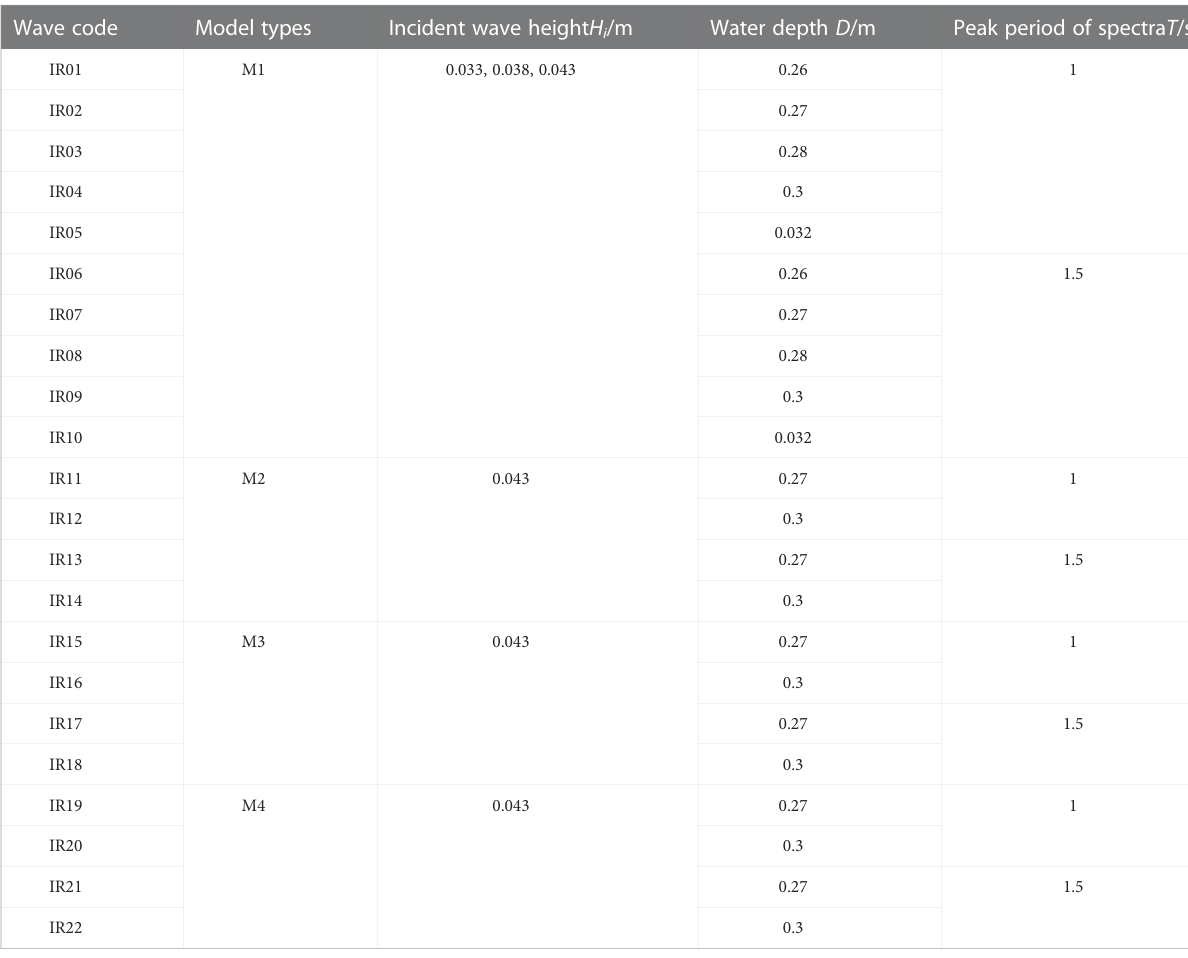
TABLE 1 Incident wave